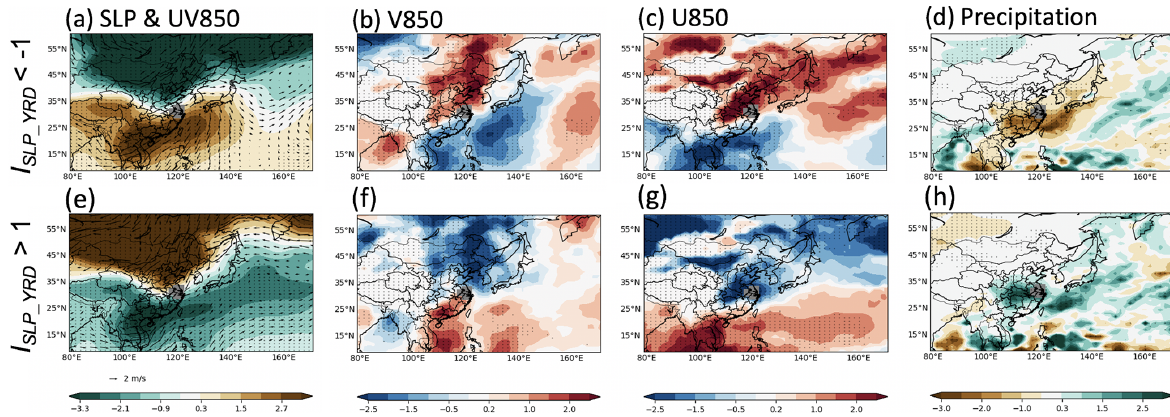
Figure 6. Anomalies (days with I SLP_YRD < − 1 minus winter mean) of (a) sea level pressure (SLP; hPa, shading) and 850hPa wind (ar- rows), (b) 850hPa meridional wind (V850; ms − 1 ), (c) 850hPa zonal wind (U850; ms − 1 ), and (d) precipitation (mmd − 1 ) from nudged UKESM1 during DJF 1999–2018 and anomalies (days with I SLP_YRD > 1 minus winter mean) of (e) SLP, (f) V850, (g) U850, and (h) pre- cipitation. Dotted regions mark statistically significant differences at the 95% level (determined through a bootstrap resampling method). Grey shading represents the YRD region.